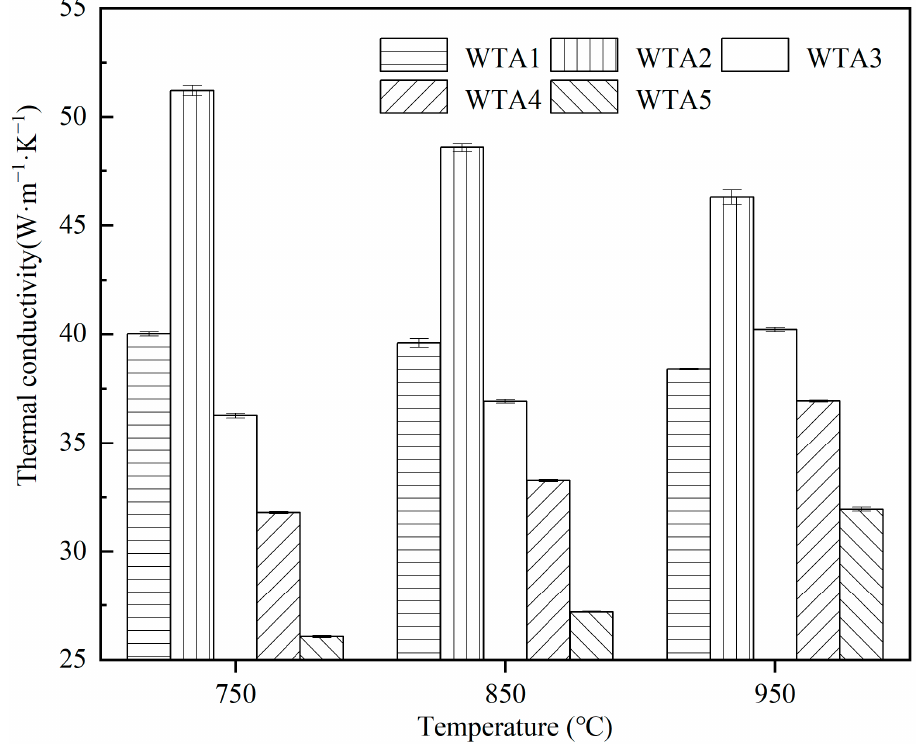
Figure 4. Thermal conductivity of WTA1–WTA5 composites at 750–950 °C.